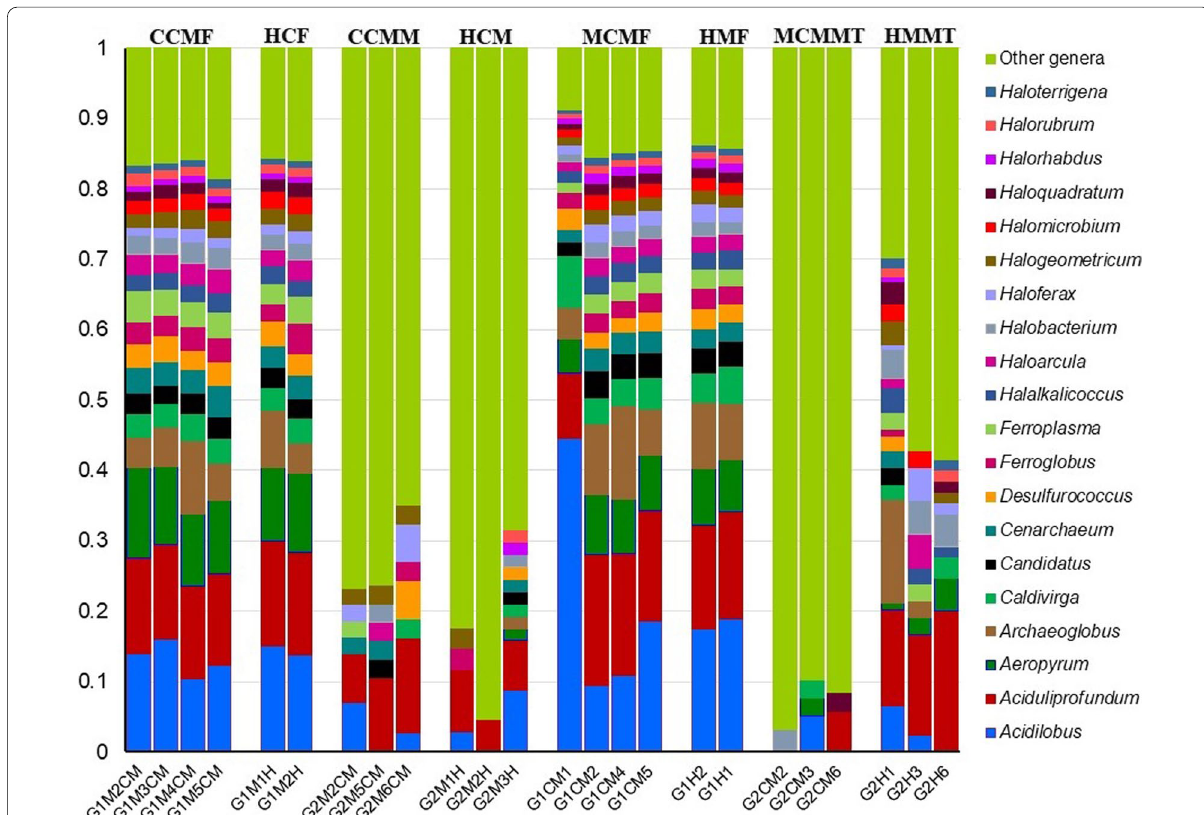
Fig. 8 The genus-level taxonomic profile of archaea identified in cow and mouse mastitis (CCMF, CCMM, MCMF, MCMMT) and healthy (HCF, HCM, HMF, HMMT) samples. Stacked bar plots showing the relative abundance and distribution of the 20 top abundant archaeal genera, with ranks ordered from bottom to top by their decreasing proportion of relative abundances, with the remaining genera keeping as ‘Other genera’. Each stacked bar plot represents the abundance of archaeal genera in each sample of the corresponding category. Notable differences in archaeal population are those where the taxon is abundant in CM (cow and mouse) samples, and effectively undetected in the H- (cow and mouse) controls. The distribution and relative abundance of the archaeal genera in the study metagenomes are also available in Additional file